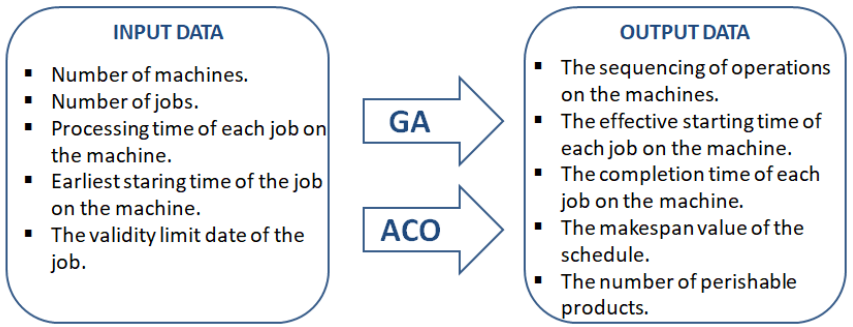
Figure 1. The input and the output of the propoed